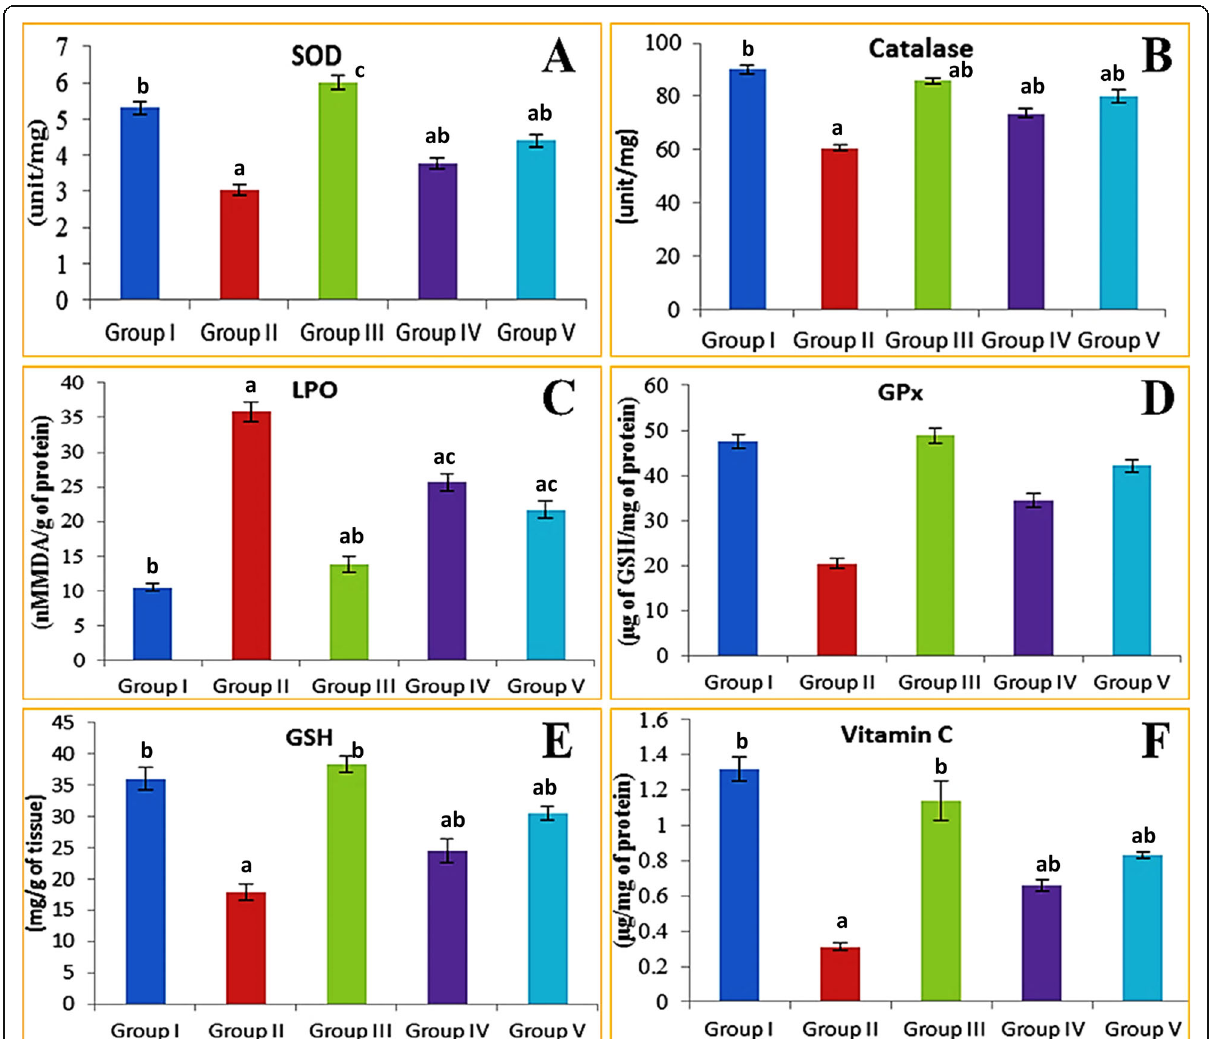
Fig. 4 Effect of ethanolic extract of T. chebula on antioxidant enzymes present in liver ( a ) superoxide dismutase, ( b ) catalase, ( c ) lipid peroxidation, ( d ) glutathione peroxidase, ( e ) reduced glutathione, ( f ) vitamin C. Values are expressed as mean ± S.D. Statistical significance ( p ) was calculated by one-way ANOVA followed by Tukey ’ s multiple comparison test. P < 0.05 was considered significant. a, P < 0.05 were considered significant compared to group I. b, P < 0.05 were considered significant compared to group II. c, P < 0.05 were considered significant compared to group I. ab, P < 0.05 were considered significant compared to group I and group II. ac, P < 0.05 were considered significant compared to group II